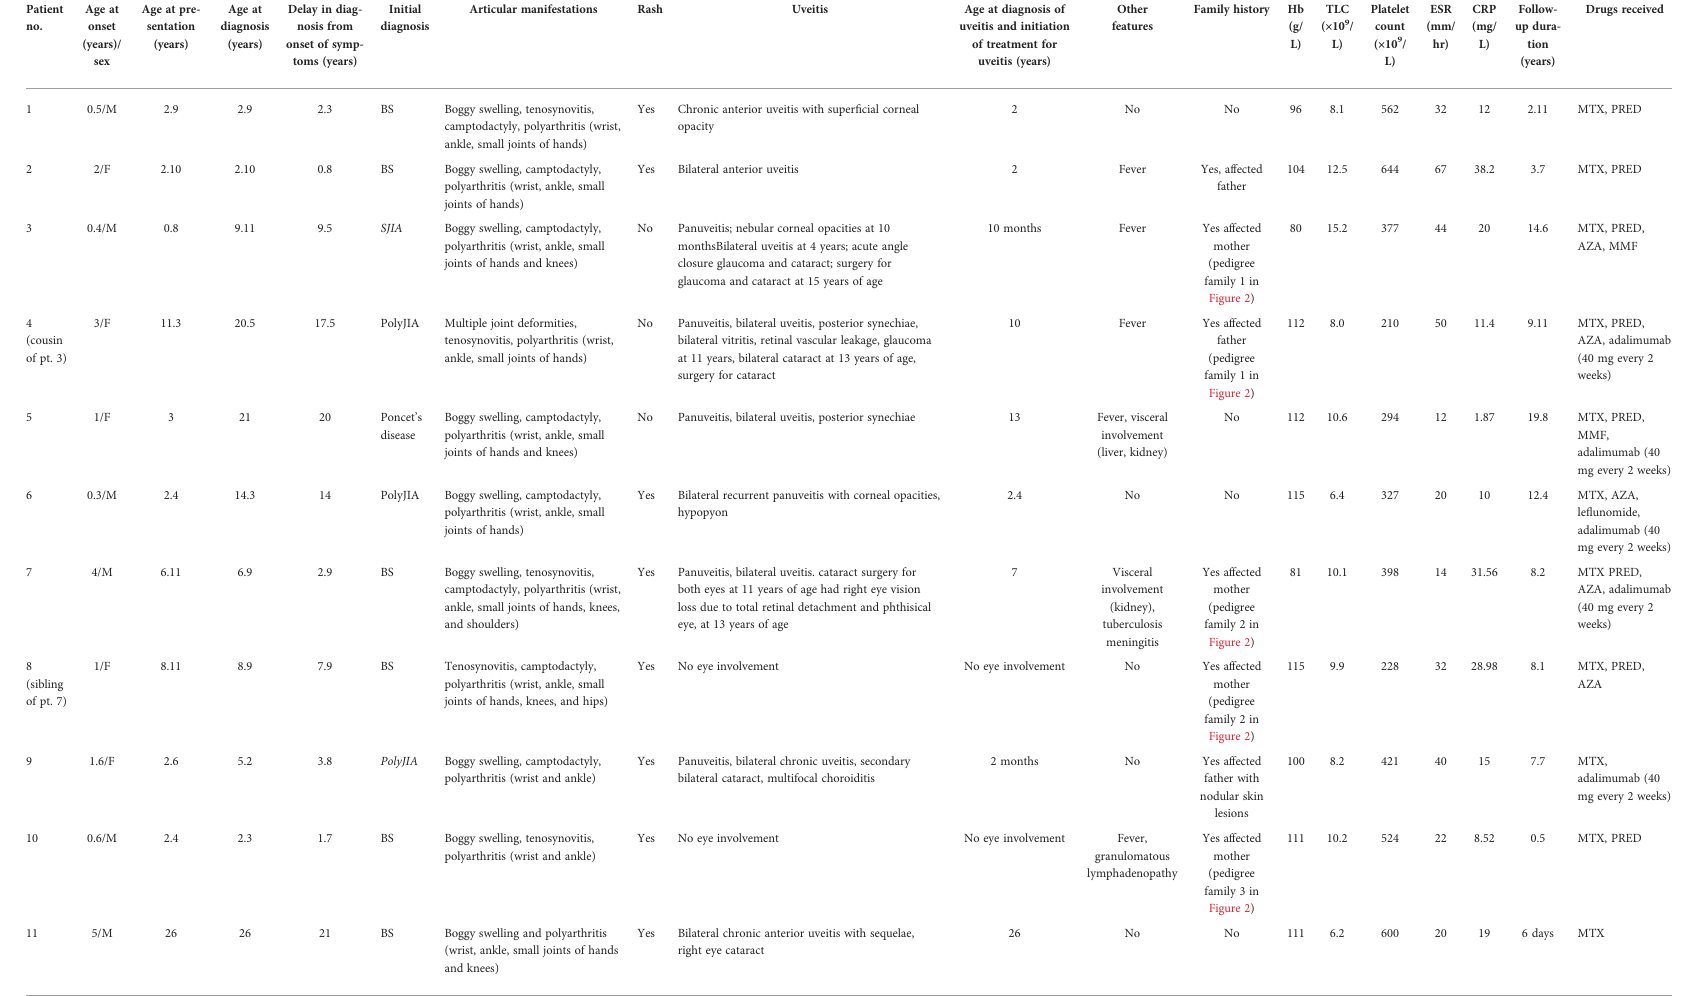
TABLE 1 Clinical features, laboratory investigations, and treatment details of patients with Blau syndrome. Patient